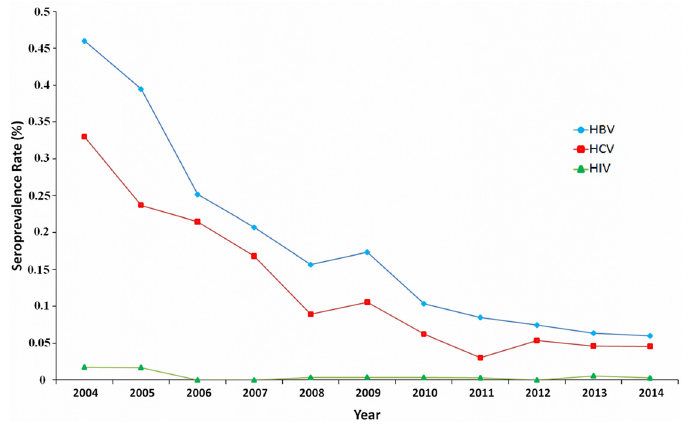
Fig 1. Trends of HBV, HCV and HIV infections among blood donors in south of Iran, 2004 – 2014.